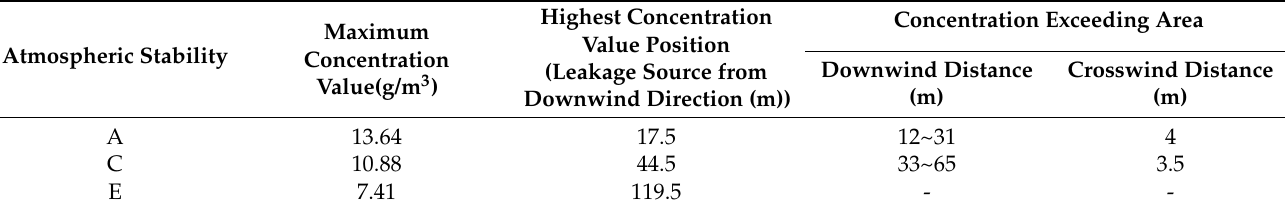
Figure 2. Regional distribution map of vinyl chloride concentration at a height of 2 m from the leak source with different atmospheric stabilities. ( a ) Concentration when atmospheric stability is class A (g/m 3 ). ( b ) Concentration when atmospheric stability is class C (g/m 3 ). ( c ) Concentration when atmospheric stability is class E(g/m 3 ). Table 5. Distribution of high-concentration hazardous areas.